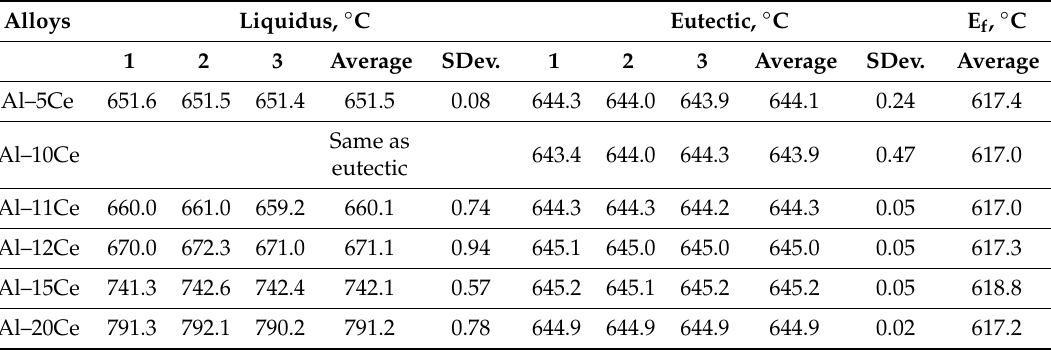
Figure 3. First derivatives of the cooling curves (dT / dt) plotted versus temperature (T) for Al–Ce alloys with marked proeutectic solidification of Al, Al 11 Ce 3 and eutectic reactions in alloys investigated: ( a ) Al–5Ce; ( b ) Al–10Ce; ( c ) Al–15Ce; ( d ) Al–20Ce. E f —end of the non-equilibrium eutectic solidification. Table 3. Liquidus and solidus / eutectic temperatures of the Al–Ce alloys determined by thermal analysis. E f —end of the non-equilibrium eutectic solidification. Average eutectic temperature obtained from the measurements of all alloys equals 644.5 ± 0.6 °C.